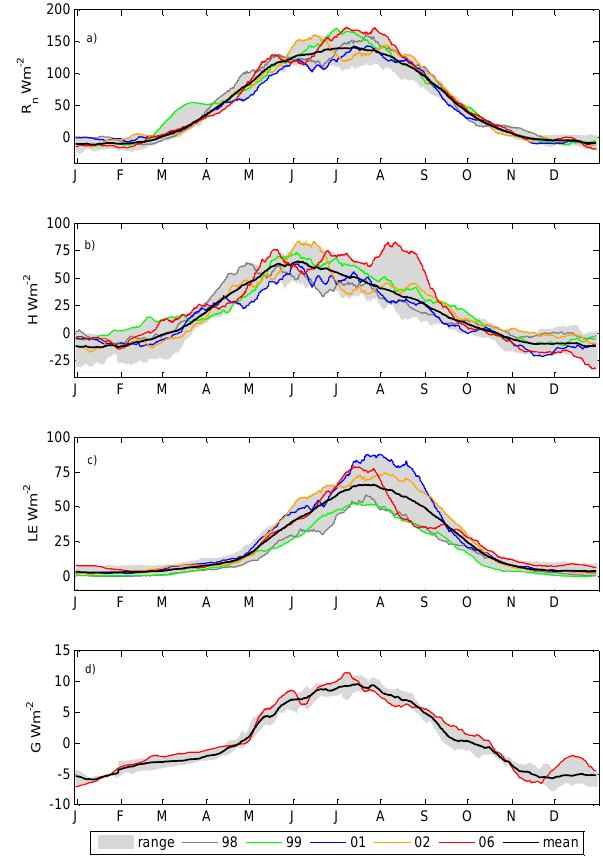
Fig. 3. Seasonal course of main energy balance terms: (a) net radia- tion ( R n ), (b) sensible heat flux ( H ), (c) latent heat flux (LE) and (d) heat flux into the soil ( G ). All data are 30-day running means. The grey area corresponds to the variability range of the 30-day running means during 1998–2008 while the average is given by the thick black line. G was not explicitly measured before year 2006. The R n and G are defined positive downwards while the sign convention is opposite for H and